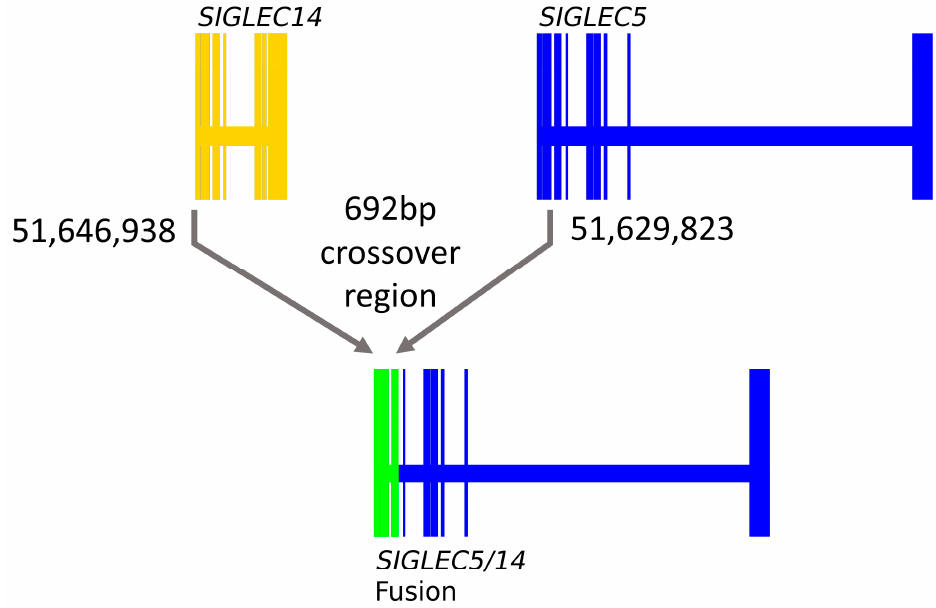
Figure 1. Identification of the SIGLEC14 deletion site. Coordinates in both are for reference genome. Exons 1-3 of SIGLEC14 and SIGLEC5 are identical which confounds exact determination of the crossover event. The yellow region depicts SIGLEC14 , the blue region depicts SIGLEC5 , while the green region depicts the 692 bp region of complete identity where the crossover deletion occurs.